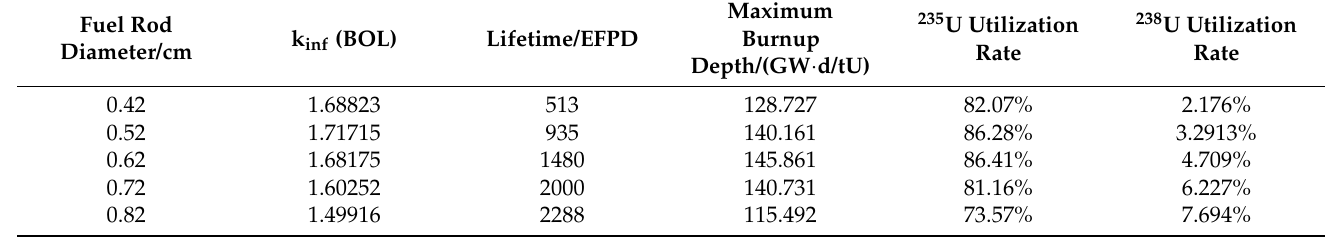
Figure 7. k inf curves with burnup depth at different fuel rod diameters. Table 6. Burnup calculation results at different fuel rod diameters.